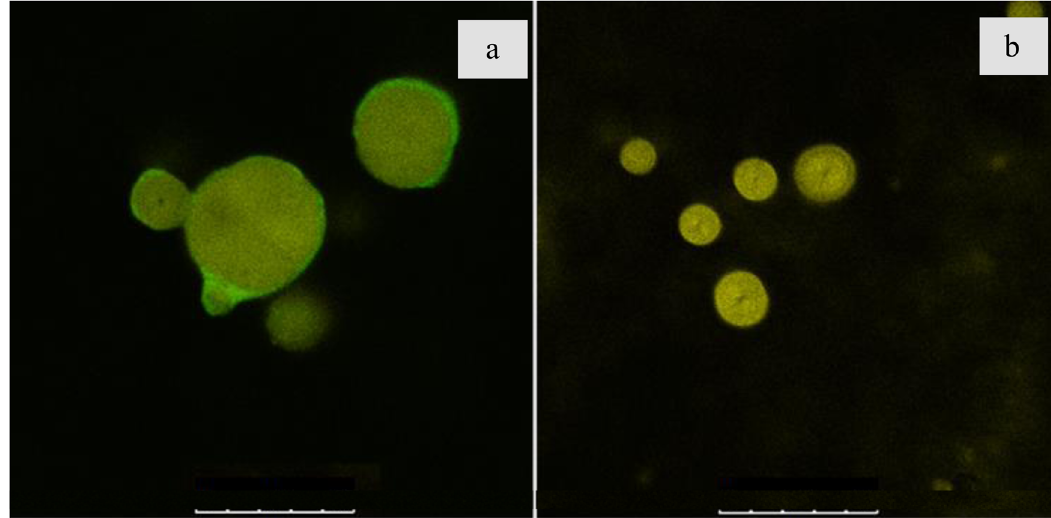
Fig. 9 Confocal microscopy images of CaCO3 precipitates deposited in vitro. a With exogenous DNA stained with Sytox green; b Without eDNA stained with Sytox green. All scale bars correspond to 25